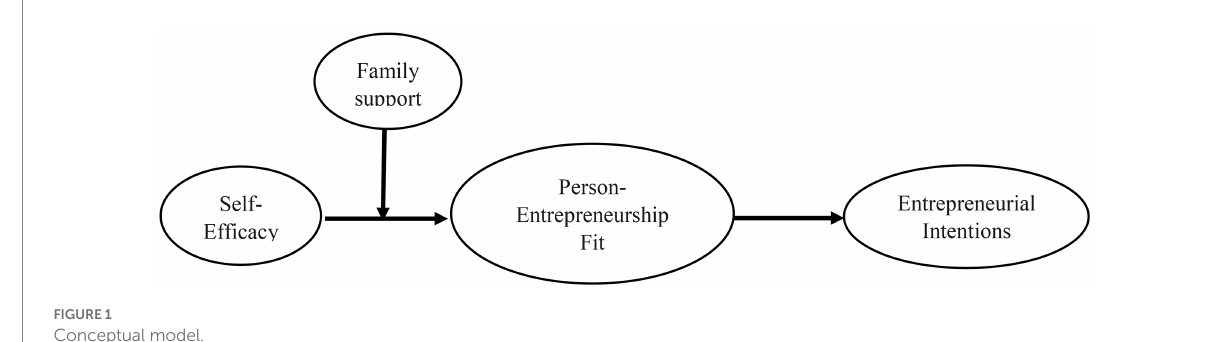
FIGURE 1 Conceptual